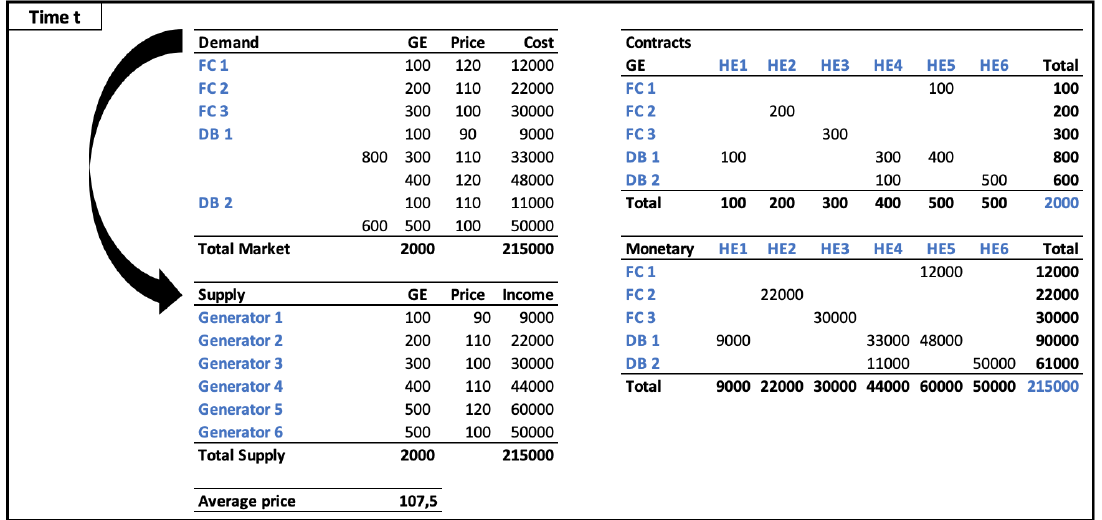
Figure 3. Specification of the case study.